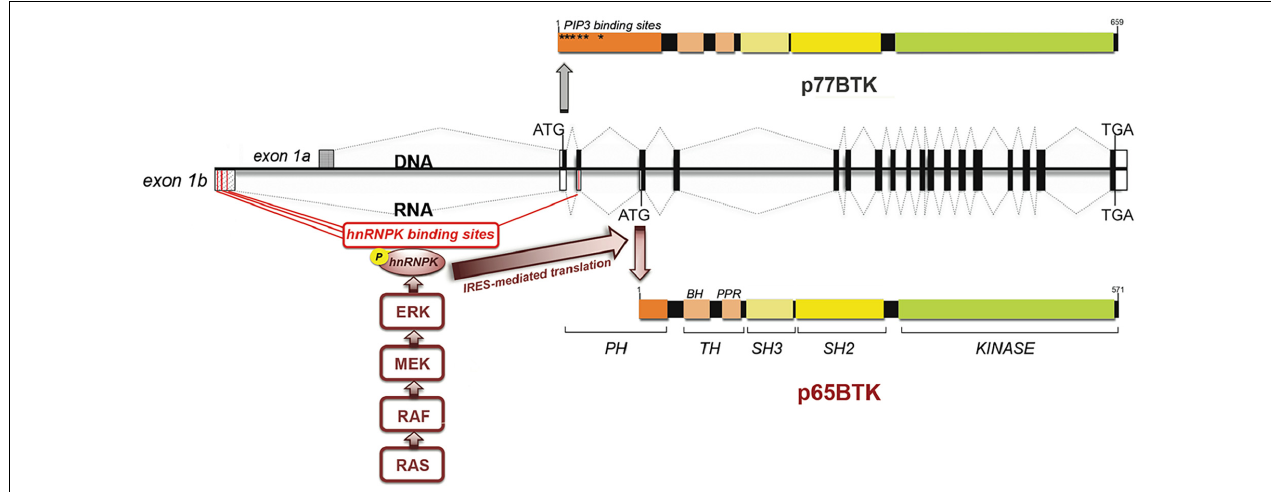
FIGURE 1 | p65BTK organization and regulation of expression. BTK gene and mRNAs encoding p77BTK and p65BTK. ATG: start codons, Black/white boxes: translated/untranslated exons. Red lines: hnRNPK-binding sites. The translation of the p65BTK-encoding mRNA occurs via an IRES-mediated mechanism and requires the binding of phospho-hnRNPK to the 5 (cid:48) UTR. The phosphorylation of hnRNPK in turns depends on ERKs, activated downstream of the RAS/MAPK